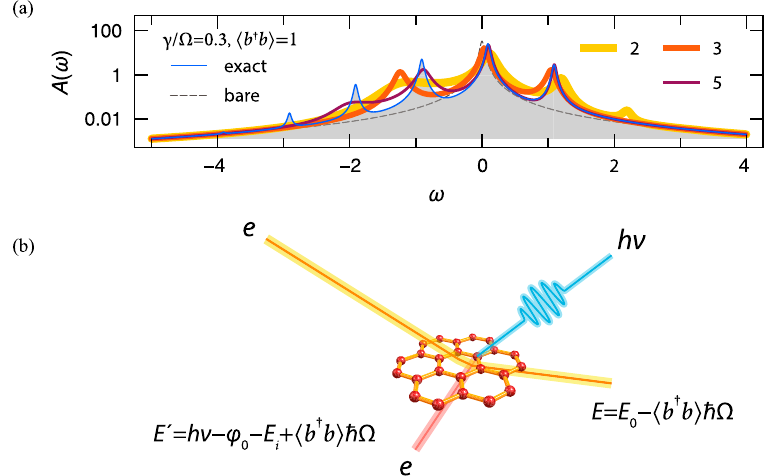
Figure 8. ( a ) Spectral function of the system with n b = 1 at different levels of theory (perturbative orders n = 2, 3, 5 are denoted by different line styles) for the following parameters:  = 0, Ω = 1, γ = 0.3, η = 0.03. Single plasmon satellite to the right of qp is a unique feature of this excited bosonic state. It can experimentally be observed in a ultrafast experiment sketched in panel ( b